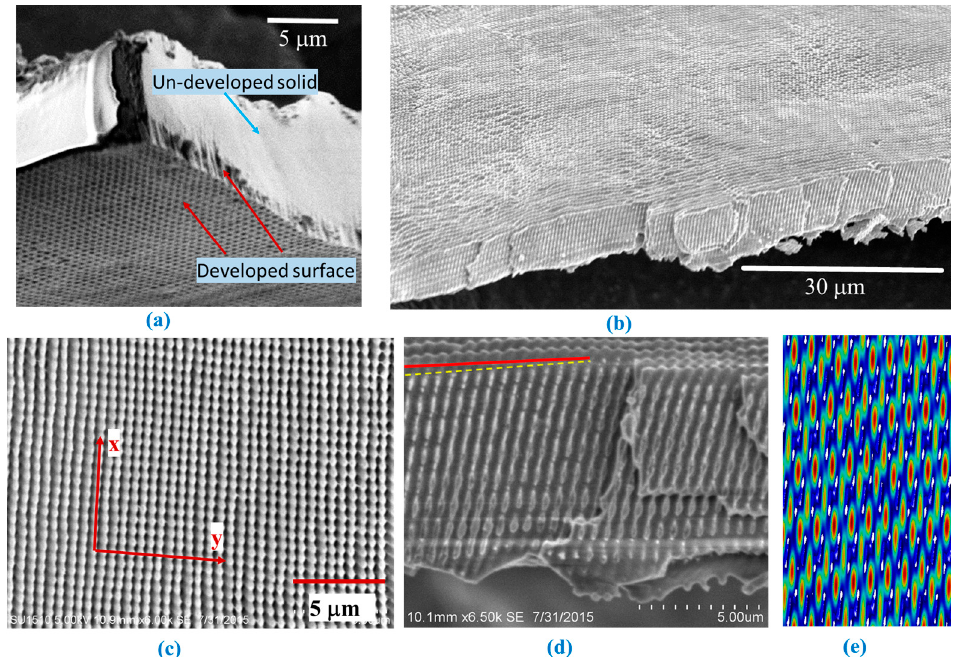
Figure 2. ( a ) Cross-section view SEM of over-exposed sample formed with 4 + 1 configuration ROE. ( b , c ) Top-view SEM of holographically fabricated, well-developed 3D structures with 4 + 1 configuration ROE with large areas showing no diffraction pattern (b) and enlarged view (c). Fabricated ( d ) and ( e ) simulated cross-sectional view of 3D structure formed with 4 + 1 configuration. The structure is not uniform as was expected due to a designed shift in the angle of incidence of a side beam. The dark-red solid line is in parallel with the sample surface and the yellow dashed line indicates the orientation of the holographic structures.